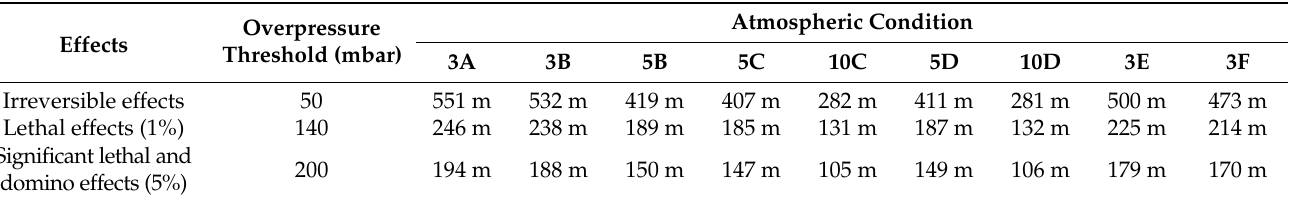
Table 10. Distances of overpressure effects generated by a UVCE in the EZ53 salt cavern scenario.